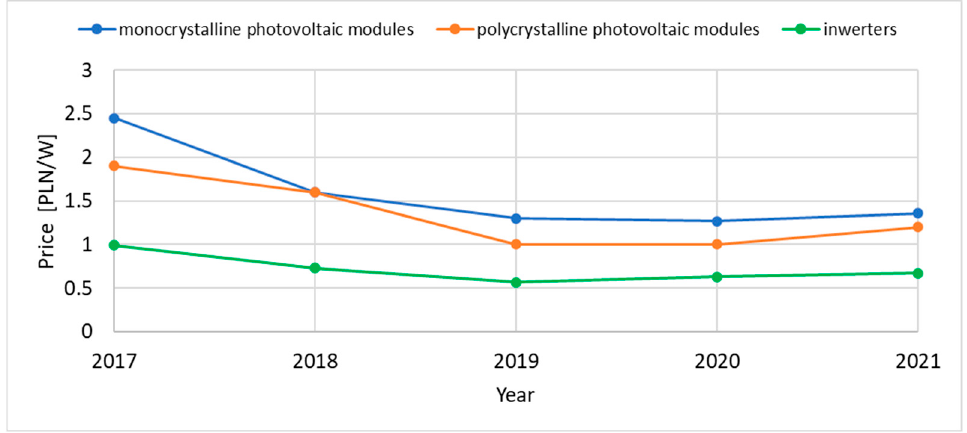
Figure 1. Average prices in 2017–2021 in Poland (own compilation of data from IEO).